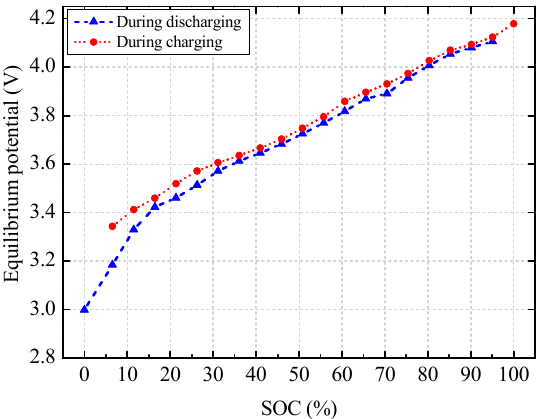
Figure 3. The measured equilibrium potential at different SOCs during charging and discharging.